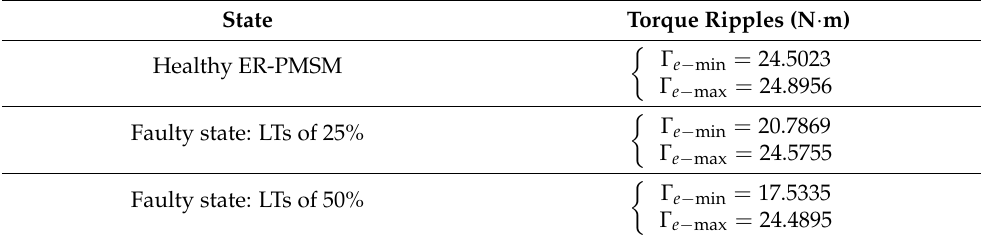
Table 2. Summary of simulation results of electromagnetic